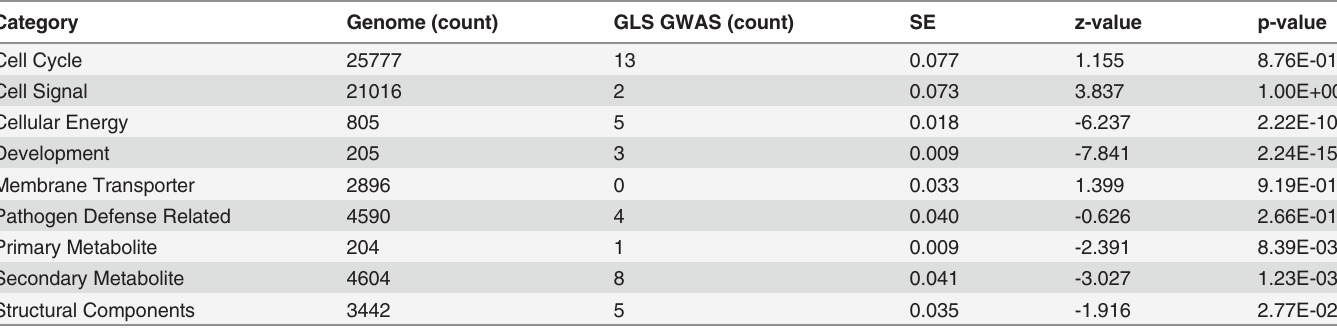
Table 3. Summary statistics of functionally annotated and categorized genome wide association hits.